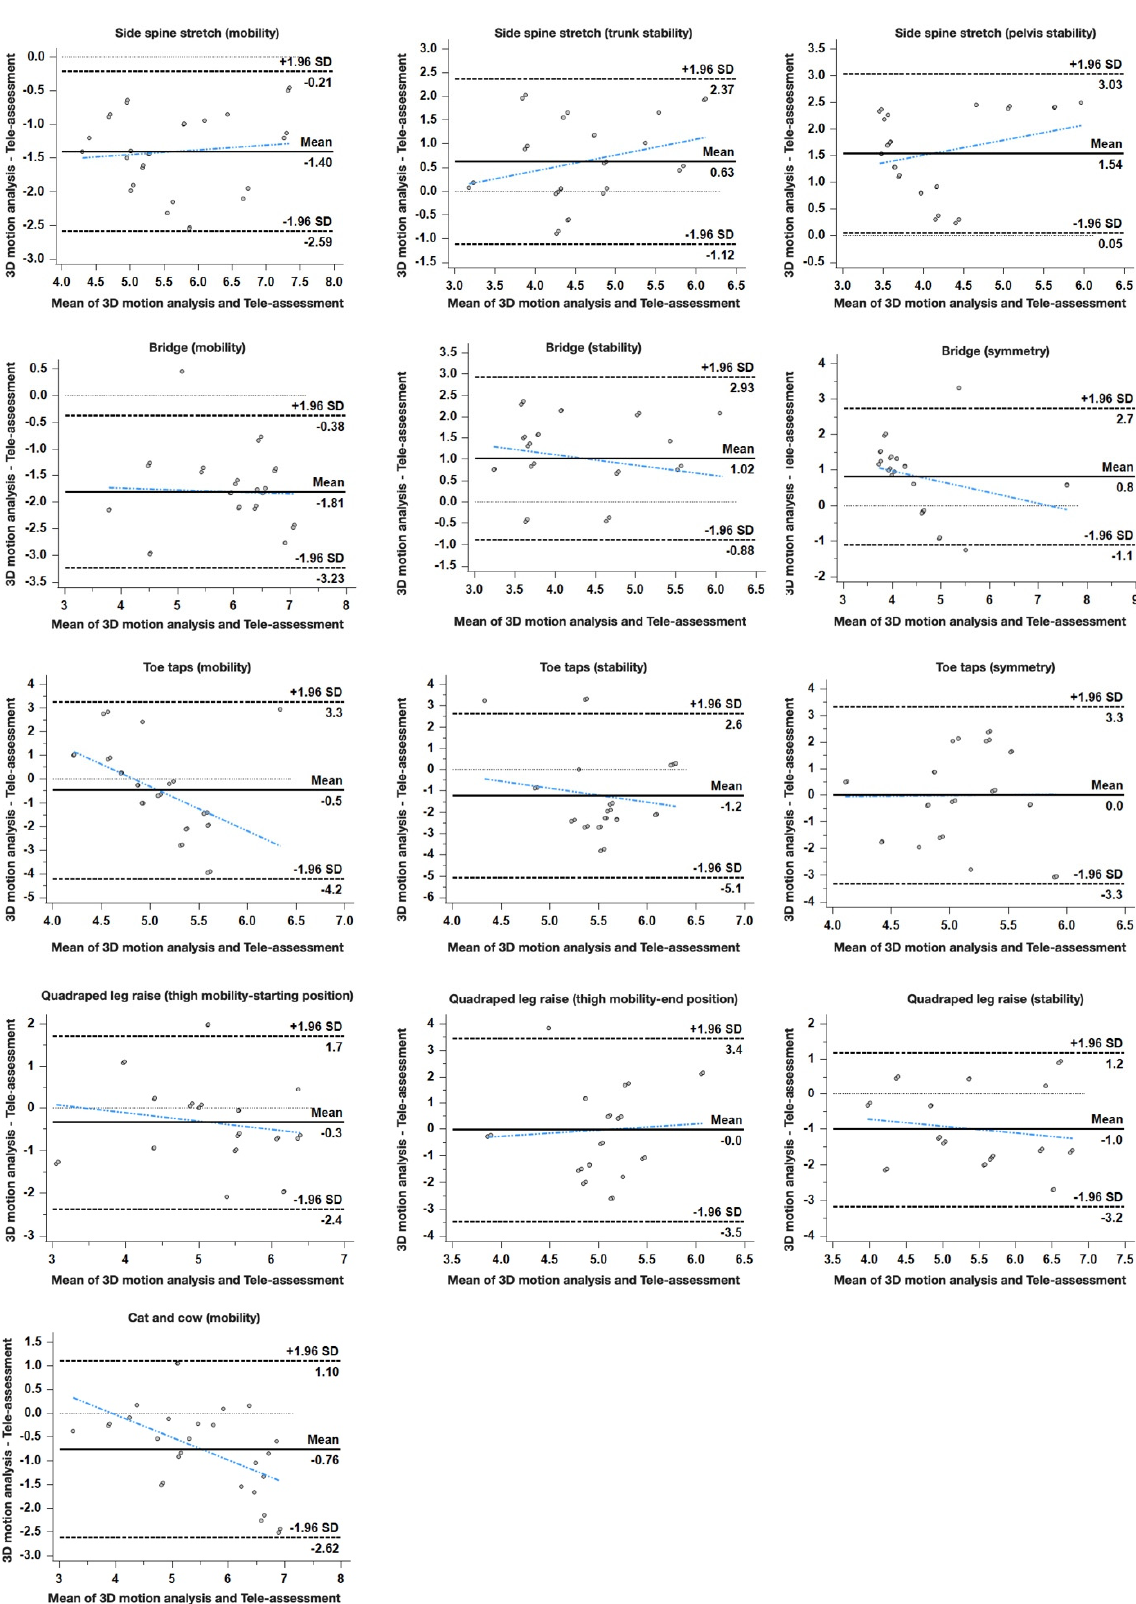
Figure 2. The Bland–Altman plot shows the agreement between 3D motion analysis and Tele-assessment using a video- conferencing application. The bold lines represent the mean difference between the two methods. The dashed lines represent 95% limits of agreement. Each row is an agreement according to the three elements of each exercise.